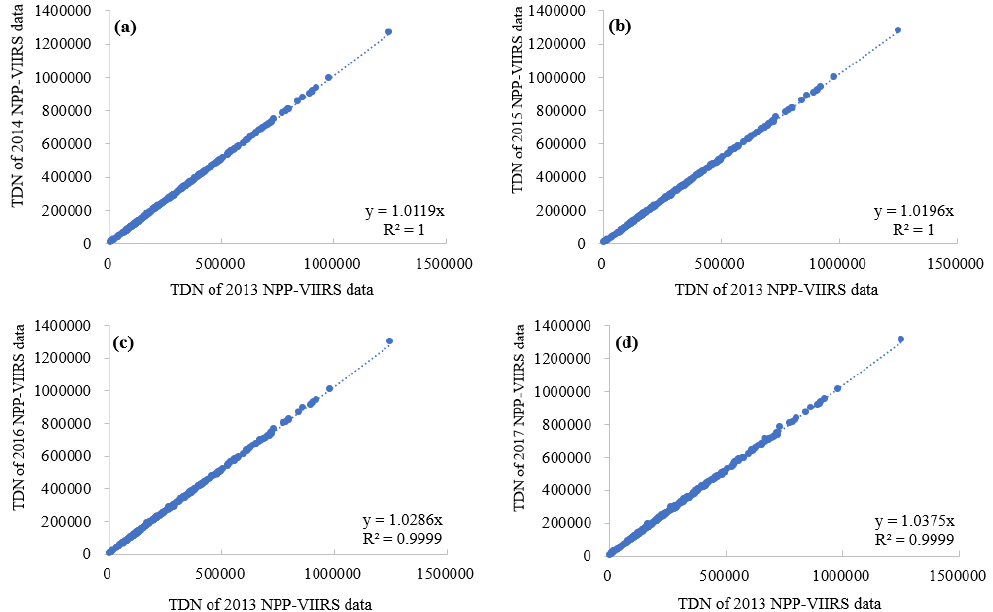
Figure 2. Liner relations between the two NPP-VIIRS data at the city level for ( a ) 2013 and 2014; ( b ) 2013 and 2015; ( c ) 2013 and 2016; and ( d ) 2013 and